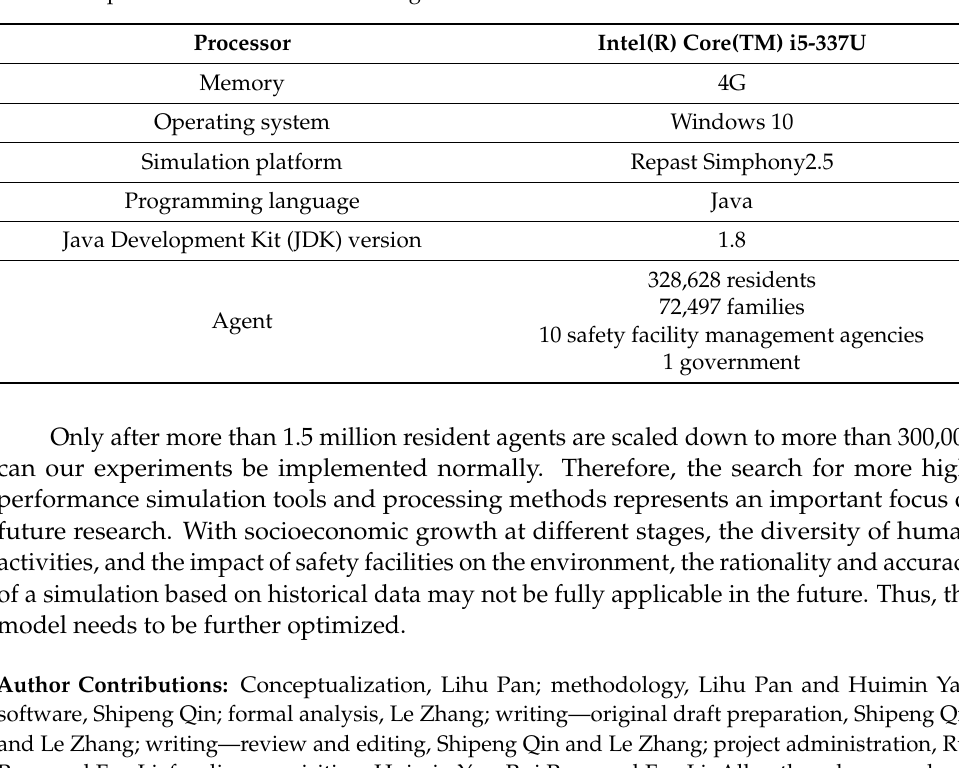
Table 2. Experimental environment and agent information in the